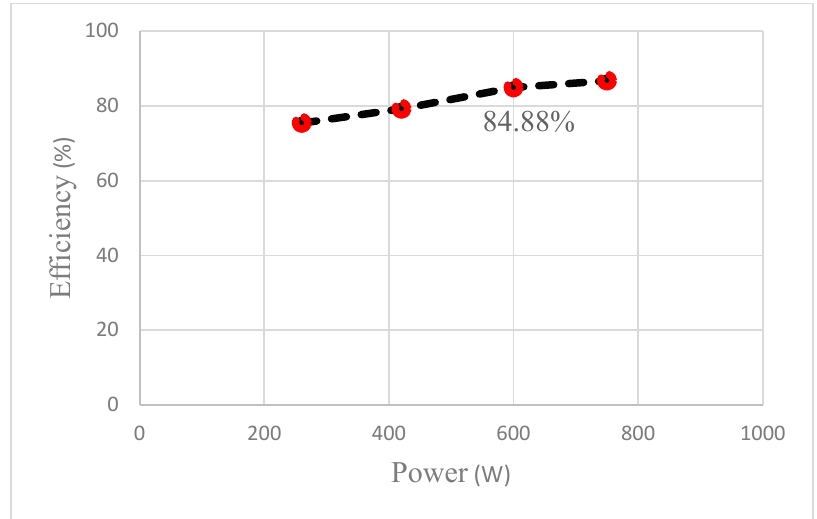
Figure 22. Efficiency curve of dual active bridge-based boost inverter.